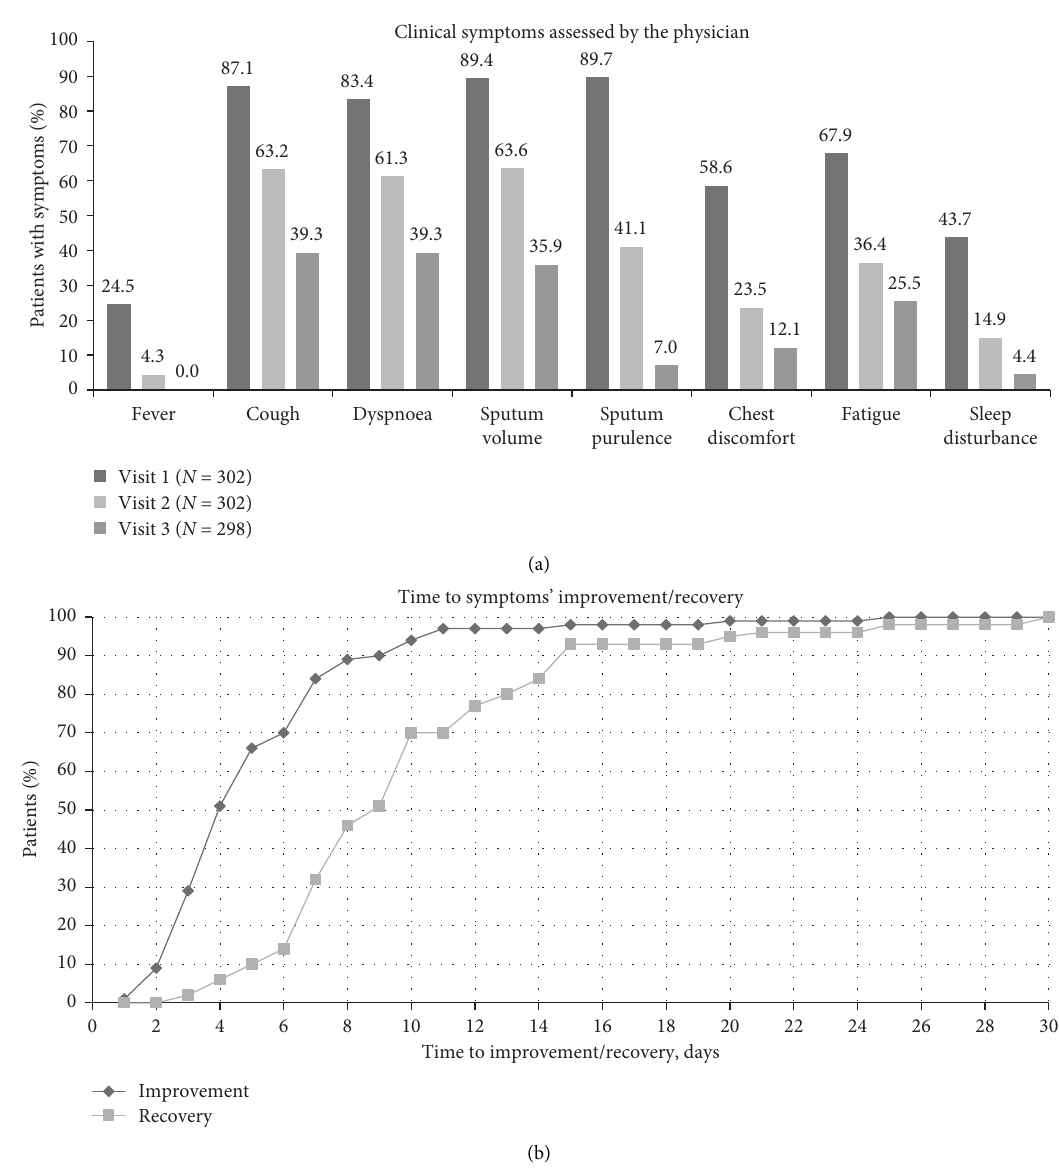
Figure 2: Patient clinical symptoms at baseline (visit 1) and the postbaseline visits and improvement/recovery during the course of the study. (a) Patients with symptoms at baseline, visit 2, and visit 3. (b) Days to the overall improvement and recovery of